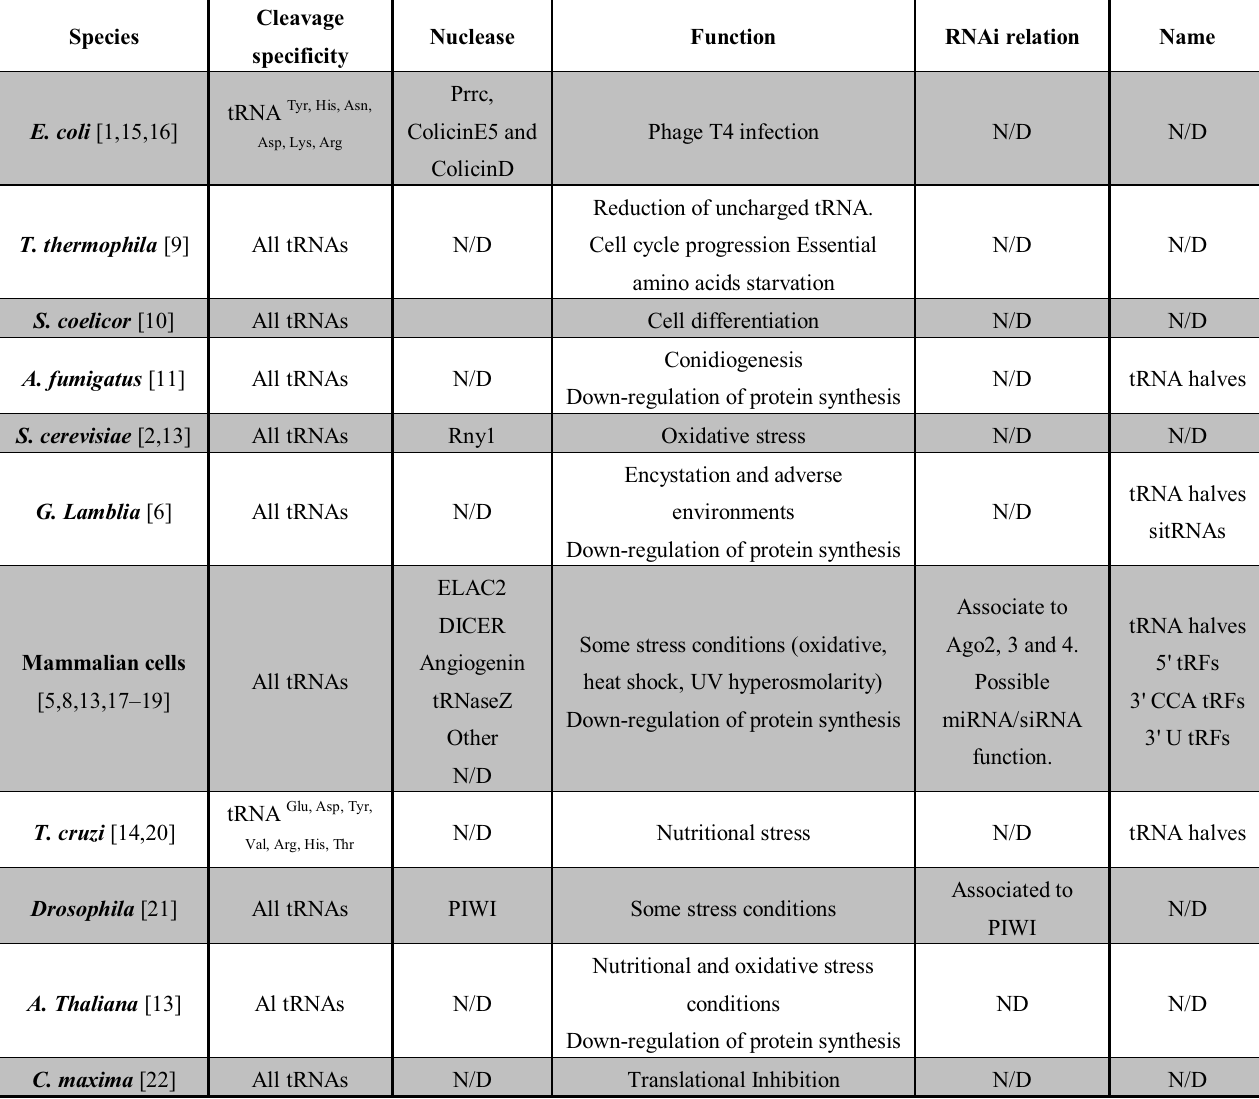
Table 1. Summary of the main descriptions made to date of tRNA cleavage phenomena in different organisms and its relation with the RNAi mechanisms (N/D: Not